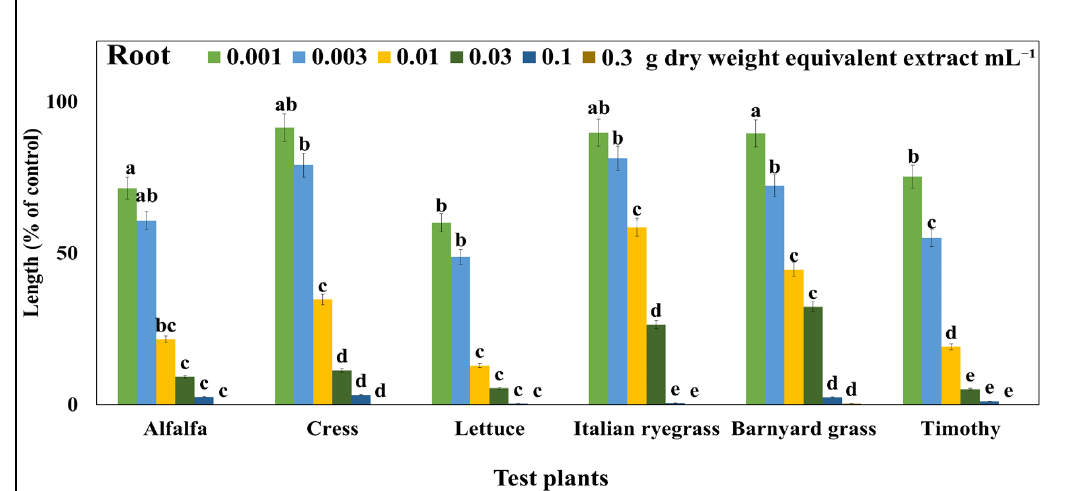
Figure 3. Root growth inhibition of the six test plants by A. reticulata leaf extract treatment at different concentrations. Mean ± SE of 2 separate experiments replicated 3 times ( n = 60). Standard error of the mean is represented by vertical bars. Differences between control and A. reticulata treatment are represented by different letters (Tukey’s HSD at p ≤ 0.05).